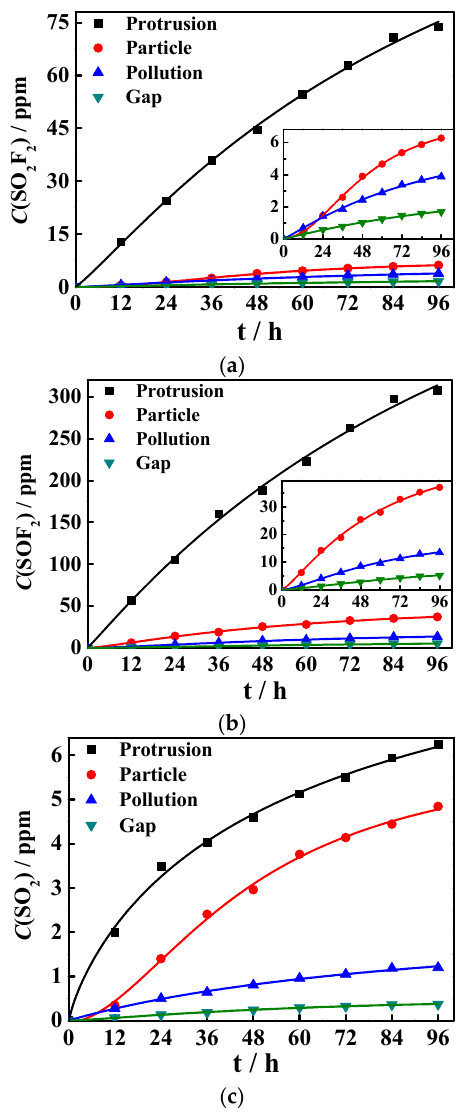
Figure 6. Change curves of the concentrations of SO 2 F 2 , SOF 2 , and SO 2 with time: ( a ) SO 2 F 2 ; ( b ) SO 2 F 2 ; and ( c ) SO 2 . and ( c ) SO 2